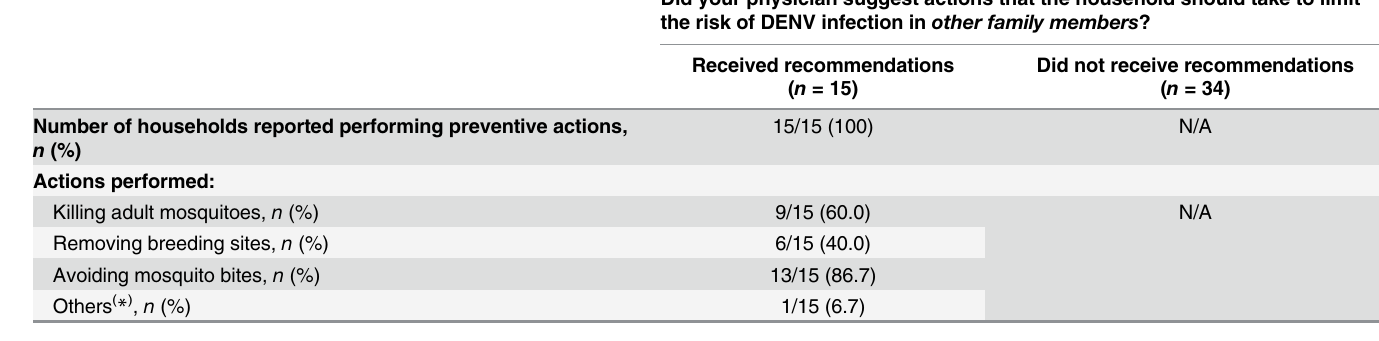
Table 4. Actions performed in patients ’ homes to prevent other family members from DENV infection. The table shows the numbers of houses, with and without having received recommendations from the attending physician, using different methods to prevent other household members from DENV